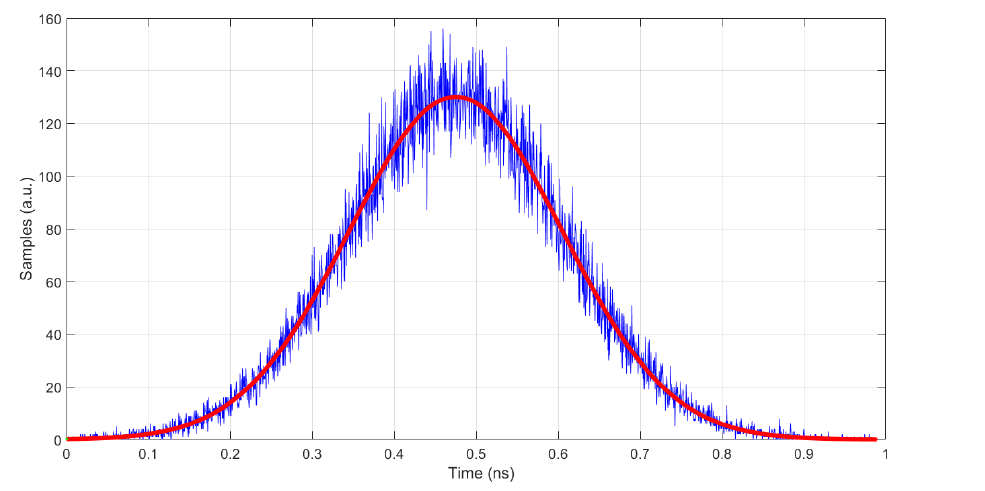
Figure 13. Skew between the electrical trigger and the trigger photo-multiplier. The data have been fit to a Gaussian function. The standard deviation is 184